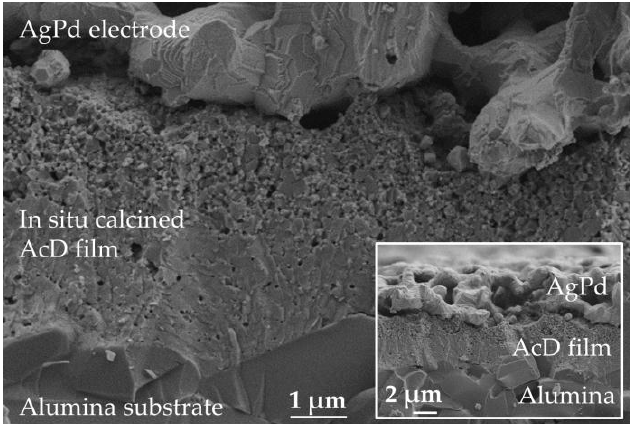
Figure 3. SEM analysis of the fracture surface after calcination of the sensor.